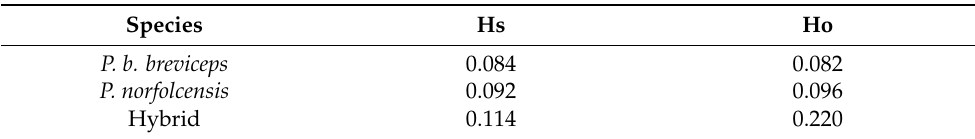
Table 3. Expected (Hs) and observed heterozygosity (Ho) of the two Petaurus species and the potential hybrid (individual